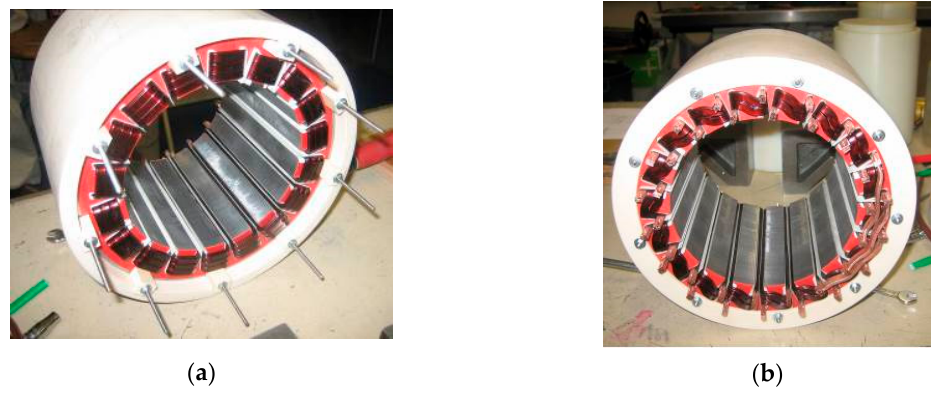
Figure 14. Stator’s active part assembling. ( a ) Front view; ( b ) back view.